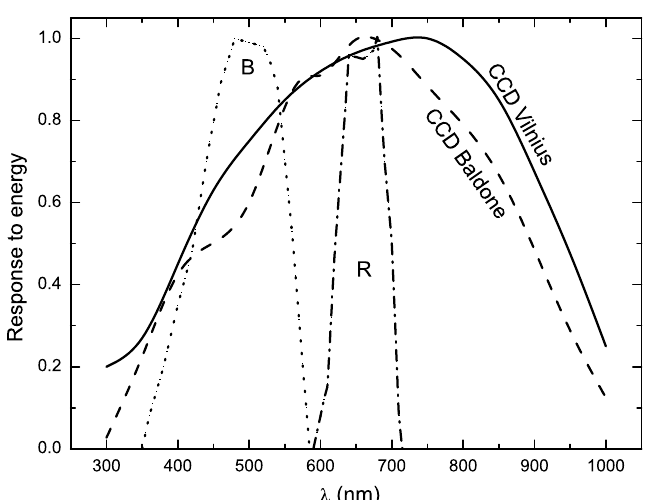
Fig. 4. Response curves of the Mol˙etai and Baldone CCD cameras and the POSS-2 blue and red magnitudes.